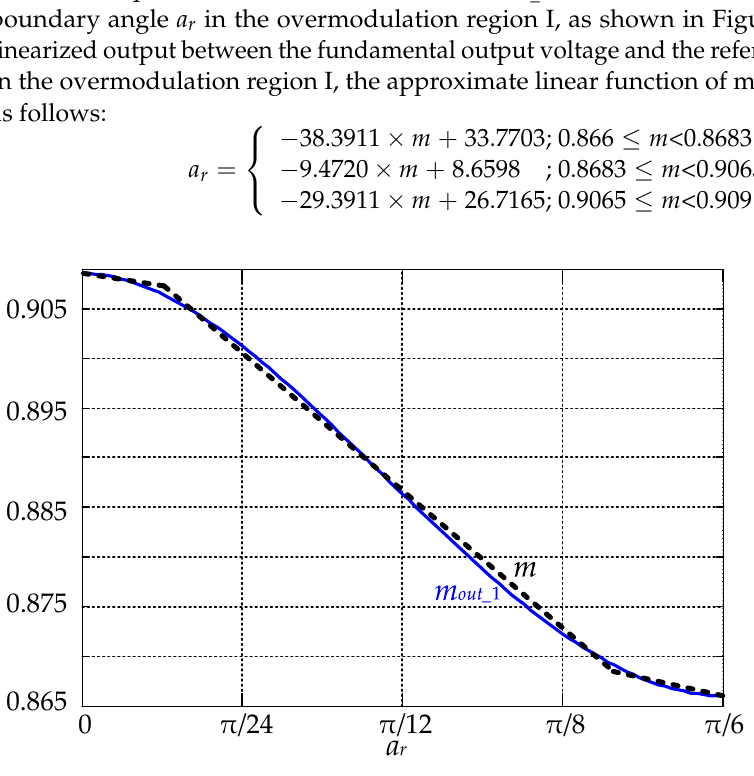
Figure 6. m out _1 and m related to a r .